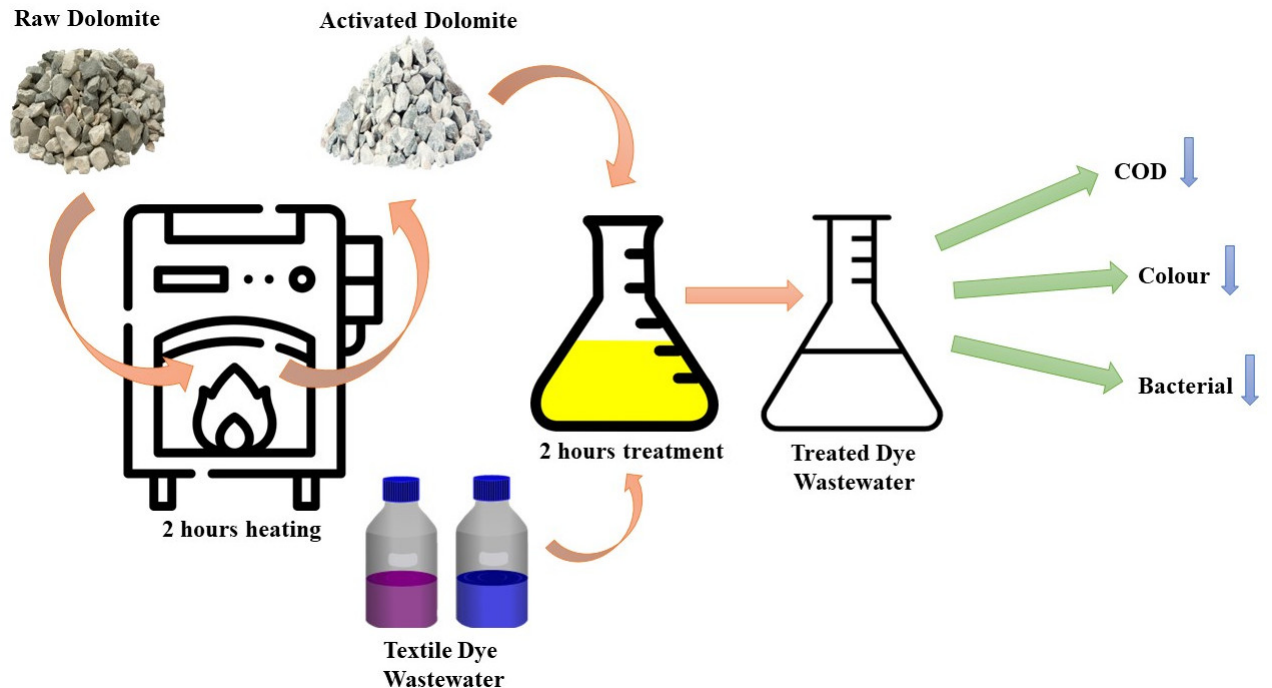
Figure 1. Graphical methodology of the treatment.